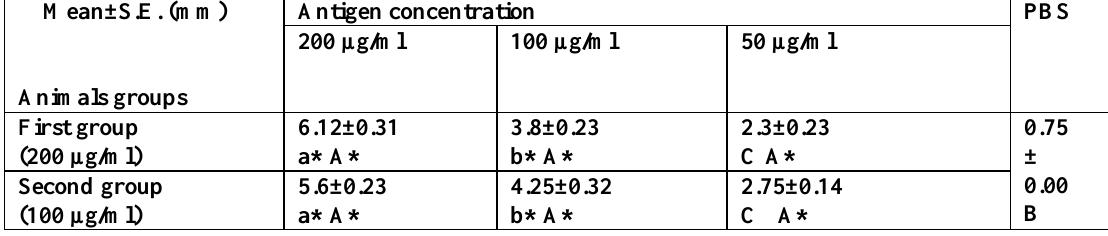
Table 4: Indurations of delayed type hypersensitivity (DTH) in the immunized rabbits with Proteus vulganis fimbriae antigen after 72 hours.